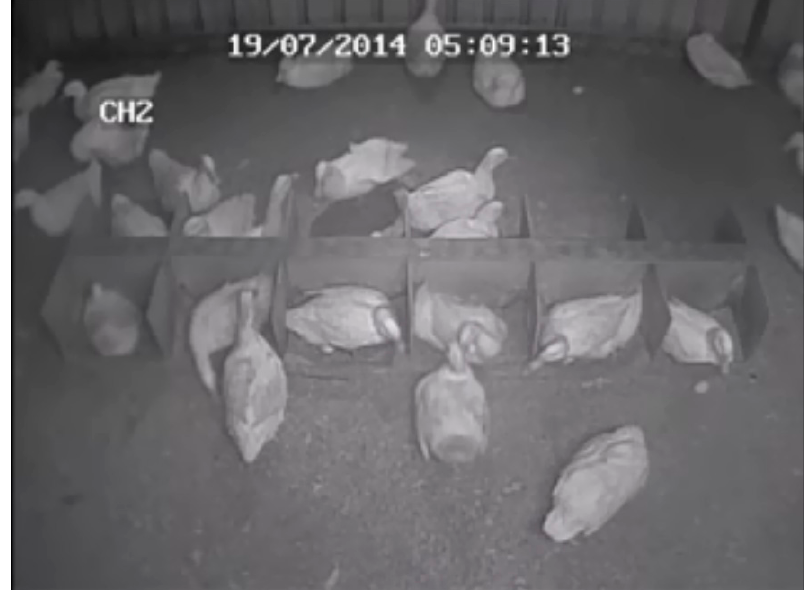
Figure 2. Still frame from video footage showing one group of 12 nest boxes used in the shed. A second group of the same layout and design is not pictured.